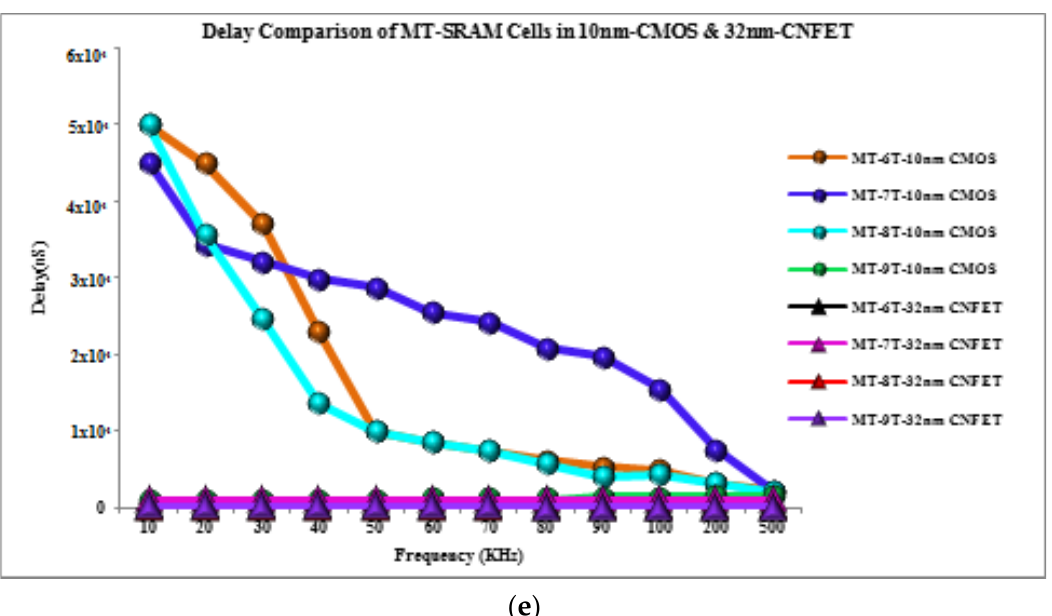
Figure 16. ( a ) Vout Comparison of Proposed MT - SRAM Cells in 10 nm - CMOS and 32 nm - CNFET. ( b ) Iavg Comparison of Proposed MT - SRAM Cells in 10 nm - CMOS and 32 nm - CNFET. ( c ) Pavg Comparison of Proposed MT - SRAM Cells in 10 nm - CMOS and 32 nm - CNFET. ( d ) Eavg Comparison of Proposed MT - SRAM Cells in 10 nm - CMOS and 32 nm - CNFET. ( e ) Delay Comparison of Proposed MT - SRAM Cells in 10 nm - CMOS and 32 nm - CNFET.